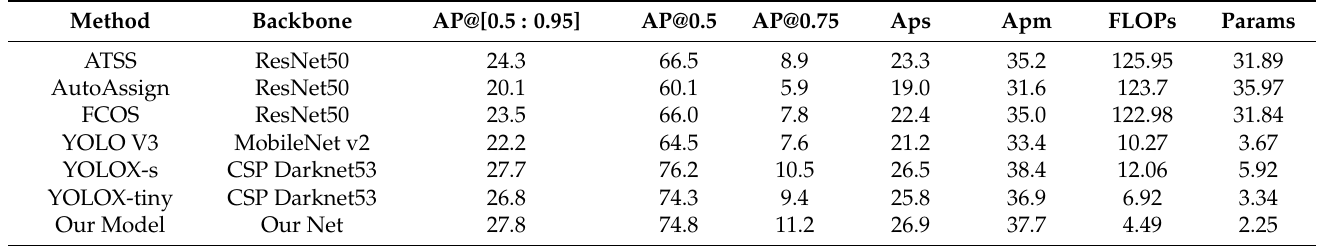
Table 6. Comparison of the performances of different methods on the